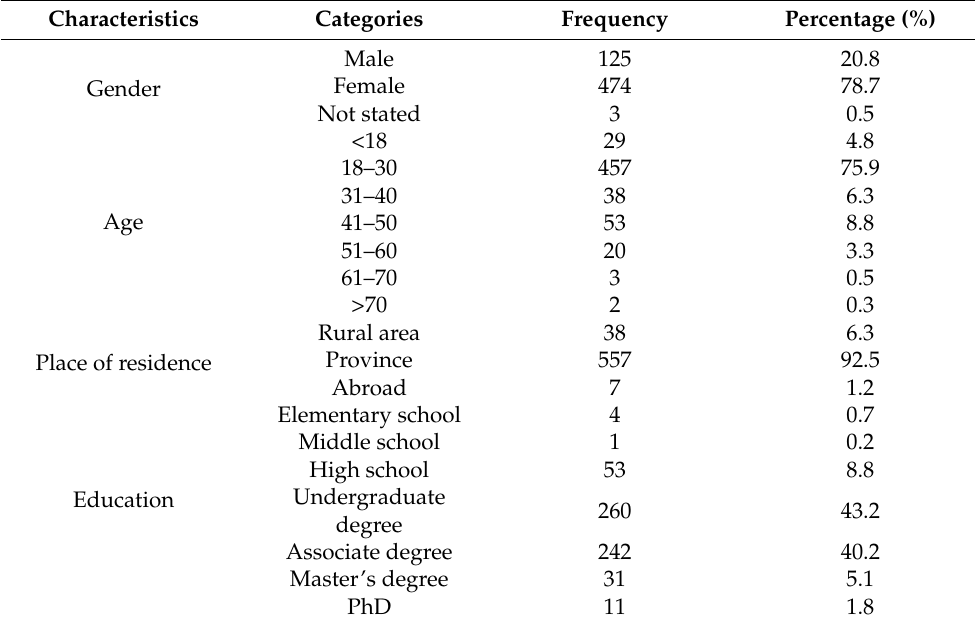
Table 1. Demographic data of participants from a cross-sectional study in Türkiye ( n = 602).